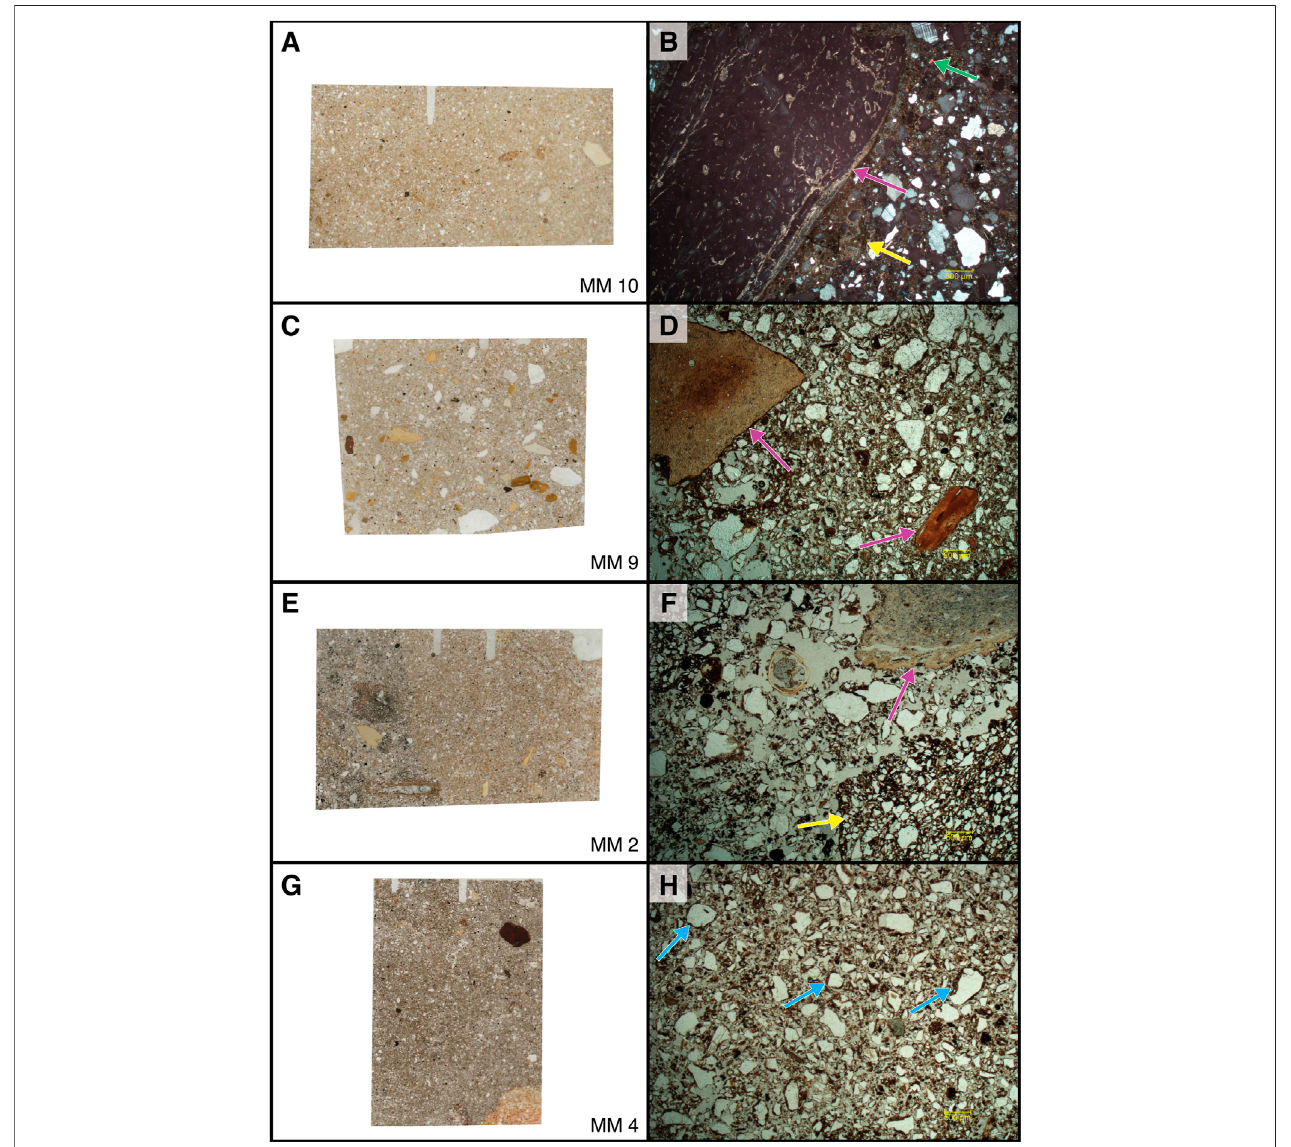
FIGURE 11 | Scans and photomicrographs of thin sections discussed in the text. Photomicrographs show the most signi fi cant features described in the text. (A) scan of thin sections of sample 10. Note the massive microstructure and the low quantity of bones included in the matrix. (B) photomicrograph of sample 10 (2x XPL) showingcementedmatrixwith micrite fi llingthespacebetween grains(yellow arrows) and coatings on largerinclusionssuch asheated bones (pink arrow). Greenarrow pointstoagrainofvolcanicmineral(possiblyolivine).Thesegrainsareverysporadicinthelowersedimentsbutincreaseinquantityintheuppersediments. (C) scan ofthin sectionsofsample 9.Notethe increase inquantity ofheatedbones and themore openmicrostructure. (D) photomicrographsample9(2xPPL) matrix containing less calcite and instead showing more redoximorphic features and a higher quantity of heated bones. However, the bones look subangular to subrounded, suggesting that they are not in primary deposition. (E) scan of thin sections of sample 2 containing the clayey in situ layer and the intrusive humic sandy layer. Note the sharp boundary between the two layers and the difference in microstructure and color between the two layers. (F) photomicrograph sample 2 (2x PPL) showing evidence of mixed matrix with aggregates ofmaterial from other layers (yellow arrow) and non-heated, diageneticallyaltered bones (pink arrow). (G) scanof thin section of sample 7. (H) photomicrographofsample7(2xPPL)intheupperlayerthematrixdoesnotcontainanyevidenceofcalcitenorheatedbones,moreoverporosityismorespongyand open and the grains all show clay coatings (blue arrows) suggesting a fast colluvial accumulation.